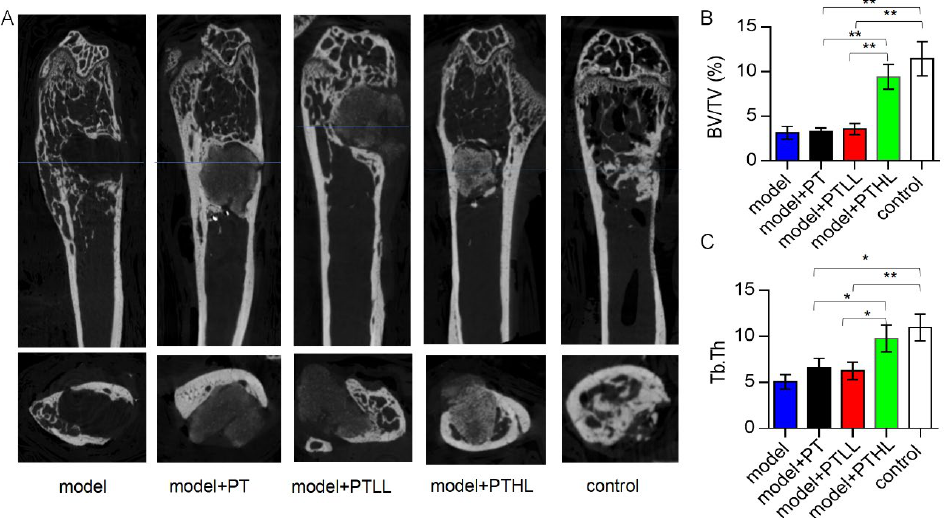
Figure 4. Micro-CT of S. aureus -infected mice femoral segmental defects implanted with various scaffolds. ( A ) Representative coronal plane and horizontal plane images of each group. Comparison of BV/TV ( B ) and Tb.Th ( C ) of each group. The parameters for new bone formation included the bone volume fraction (BV/TV, %, as the volume of mineralized bone per unit volume of the sample) and trabecular thickness (Tb.Th, mm, as the thickness measurement of cancellous bones). Student’s t -test, mean ± sd, * p < 0.05, ** p < 0.01.